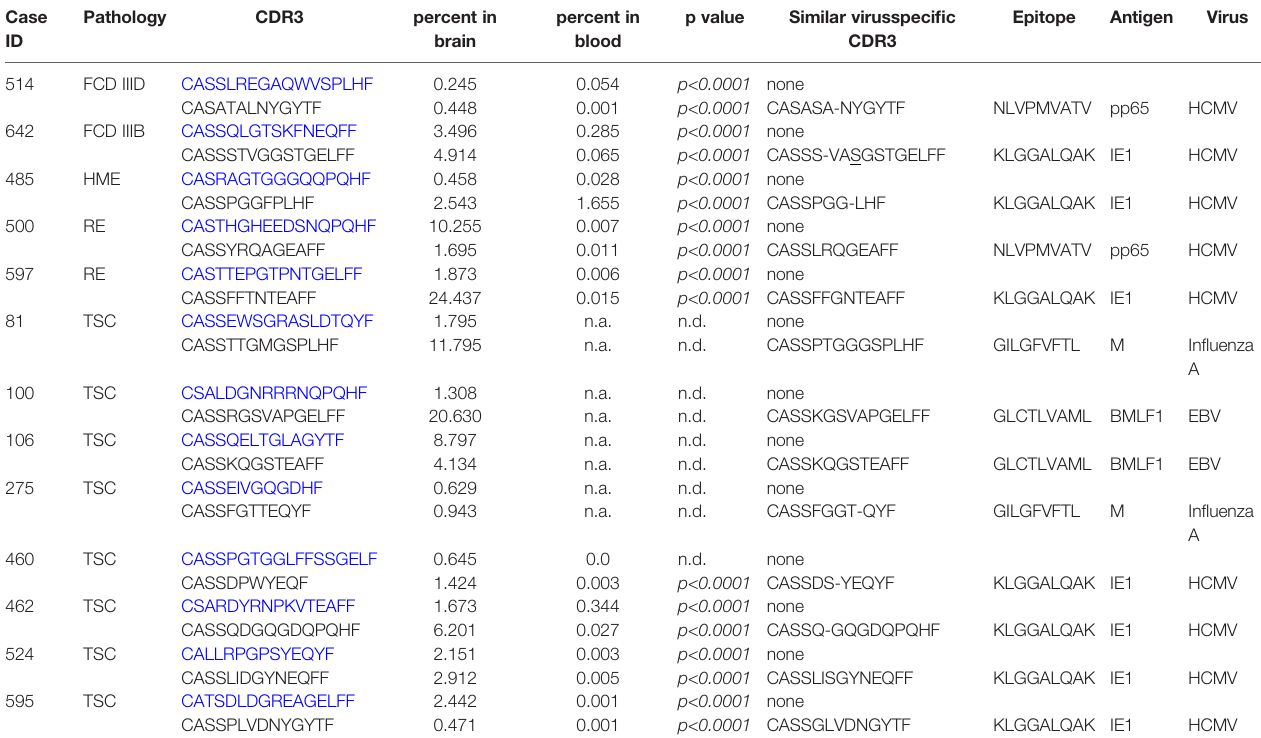
TABLE 2 | Frequency of the top private and public V b CDR3